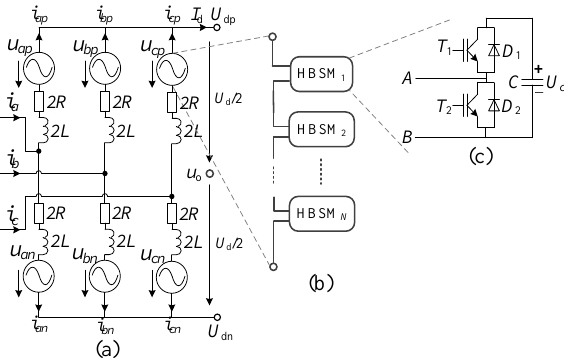
Figure 1. System connection form of SNOP.